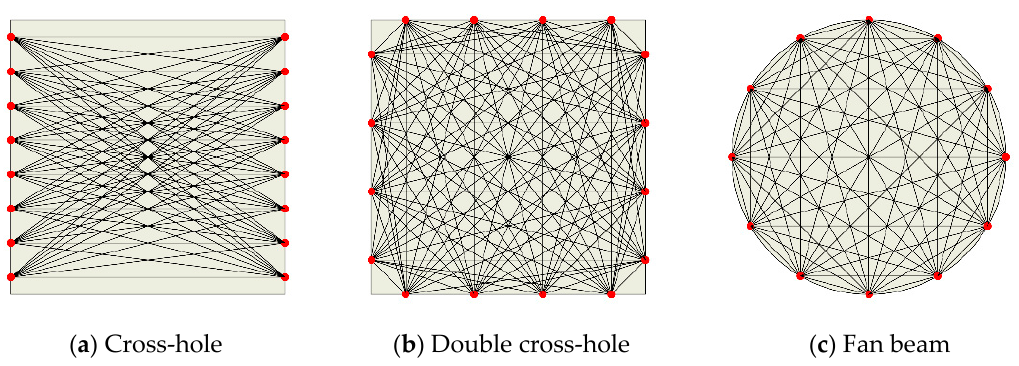
Figure 1. Transducer array of conventional LWTs.